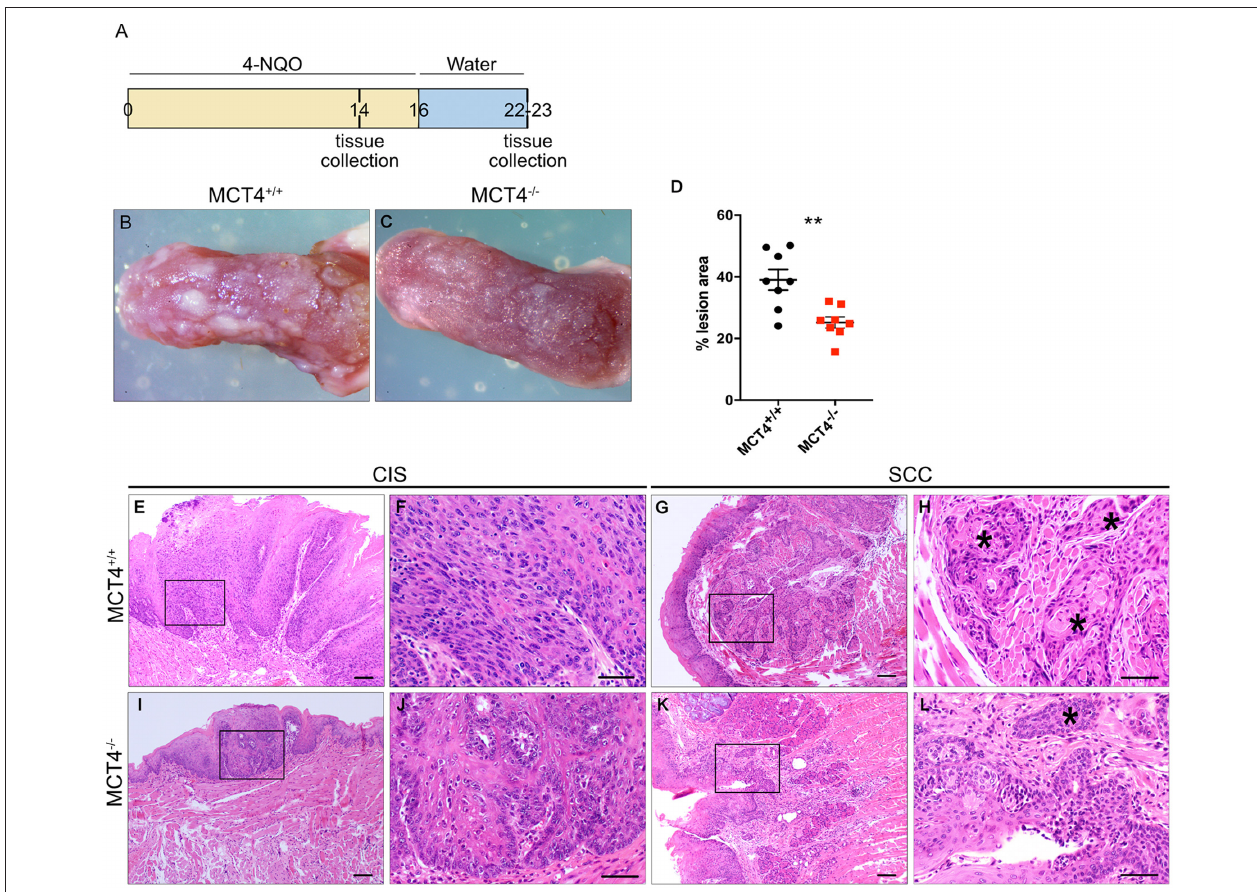
FIGURE 3 | Reduced invasive oral squamous cell carcinoma in MCT4 − / − mice after 4NQO: Study design: 12 week old mice were treated for 16 weeks with 4NQO (50 µ g/ml) in the drinking water, followed by 7 weeks of plain water. Mice were sacrificed after 14 weeks of treatment or at 23 weeks (A) . Photographs of wild type (B) and MCT4 − / − (C) tongues after 23 weeks of treatment. Quantification of superficial lesions expressed as percentage of total dorsal tongue surface area ( n = 8 per group), ** p < 0.01 (D) . Representative H&E stained paraffin sections of tongues from wild type and MCT4 − / − animals treated with 4NQO and sacrificed at 23 weeks (E–L) CIS, carcinoma- in-situ ; SCC, invasive squamous cell carcinoma. F, H, J and L are higher magnifications of E, G, I and K respectively. *Indicates invasive SCC. Scale bar: 100 µ m (F,H,J, L) or 50 µ m (E,G,I,K)